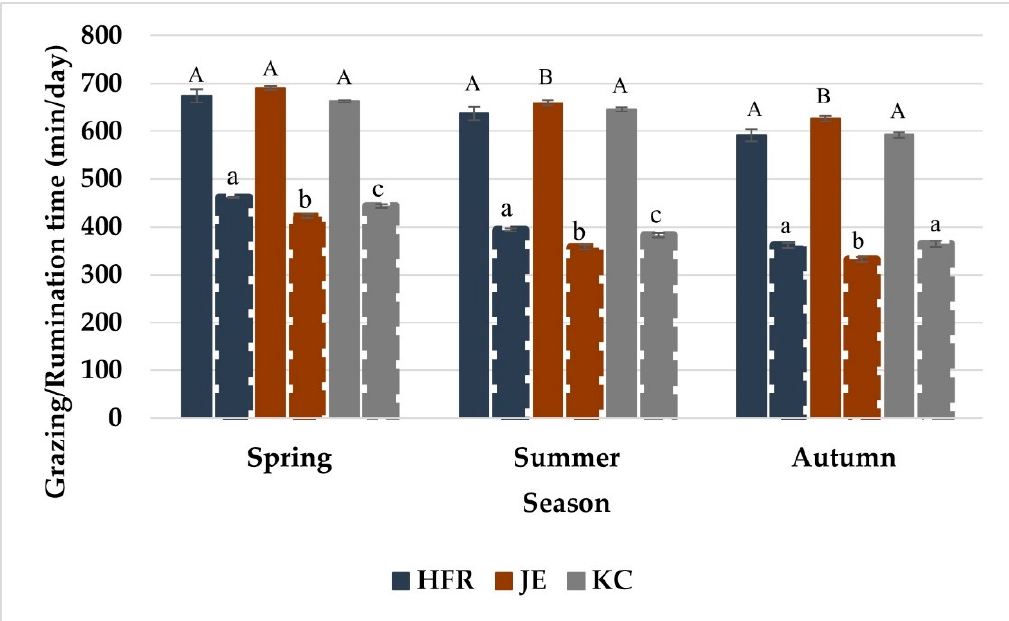
Figure 3. Grazing time (min/day) and rumination time (min/day) of Holstein-Friesian (HFR), Jersey (JE) and KiwiCross (KC) cows across three seasons over the lactation period for Year-1 of the study period. Compact bars show grazing time and dotted bars show rumination time. Error bars represent standard error. Letters on each bar show significant differences between bars, capital letters for grazing time and small letters for rumination time.